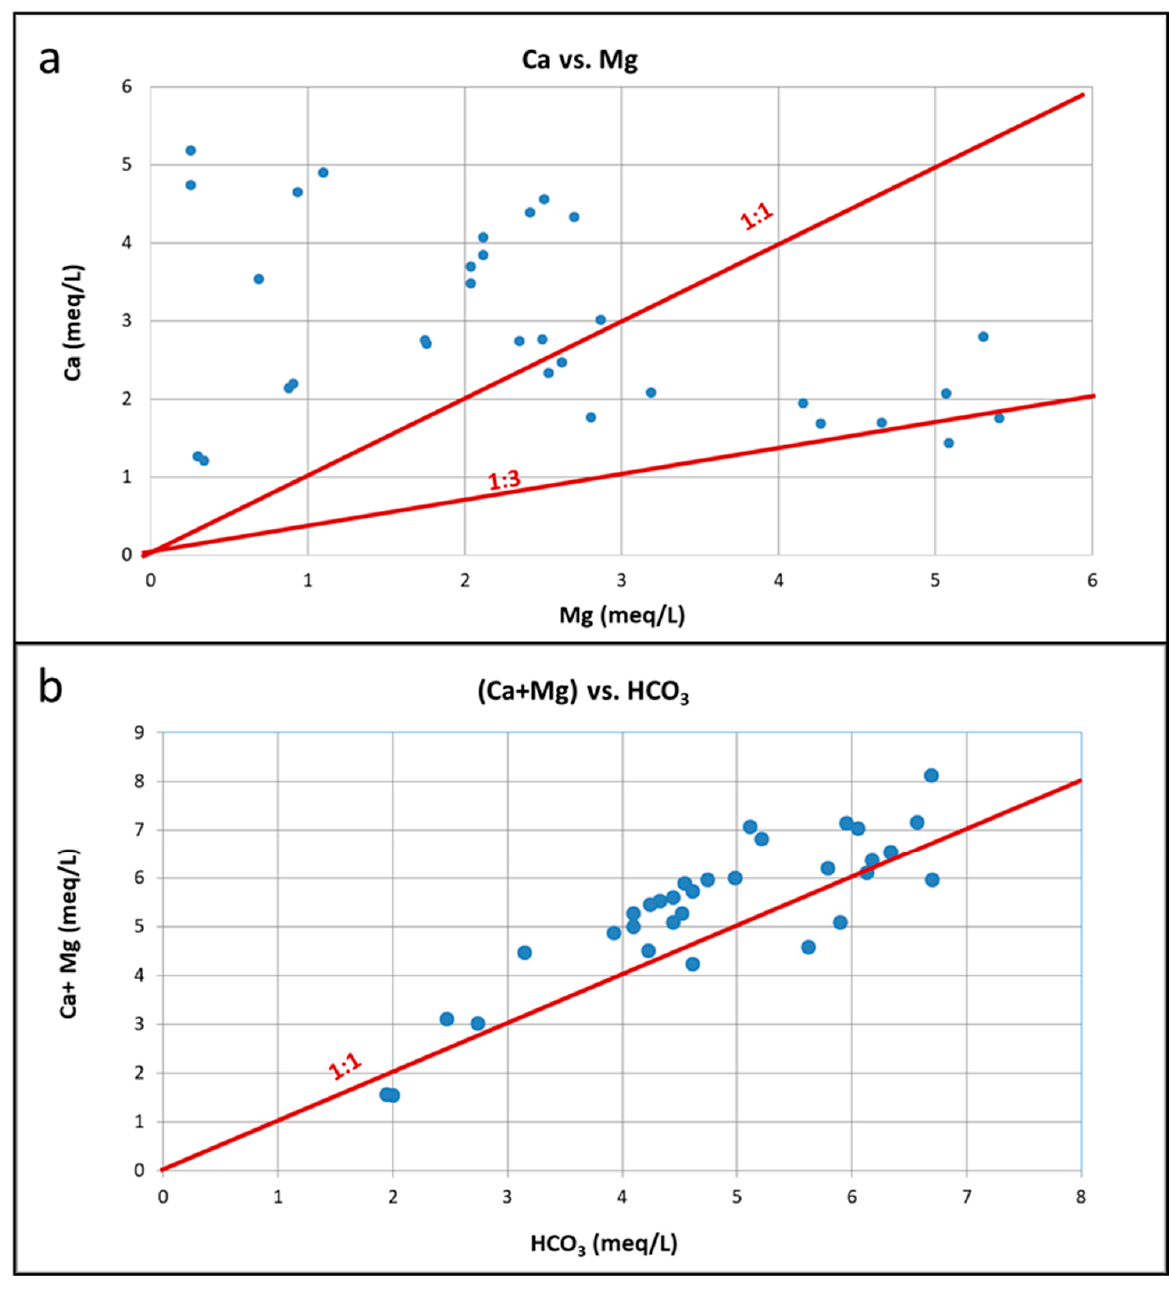
Figure 13. Bivariate plots of: ( a ) Ca vs. Mg and ( b ) (Ca+Mg) vs. HCO 3 for the natural springs of western Vermio Mt. An interesting feature of the spring “Potistis”-W13, derived from the evaluation of hydrogeochemical, hydrological, and meteorological data, is the decrease in concentrations of Cr in a very short time after rainfall; this is further supported by the strong linear regression of Cr vs. discharge (coefficient of determination R 2 = 0.85) (Figures 16 and 17). Low discharge results in increased water–ultramafic rock contact time and thus, in elevated concentrations of